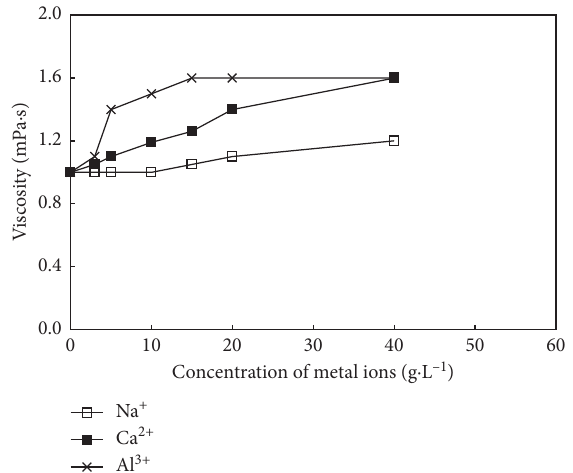
Figure 7: Effect of metal ions addition (Al 3+ ( × ), Ca 2+ ( ■ ), and Na + ( □ )) on the viscosity of a zinc ore slurry (after